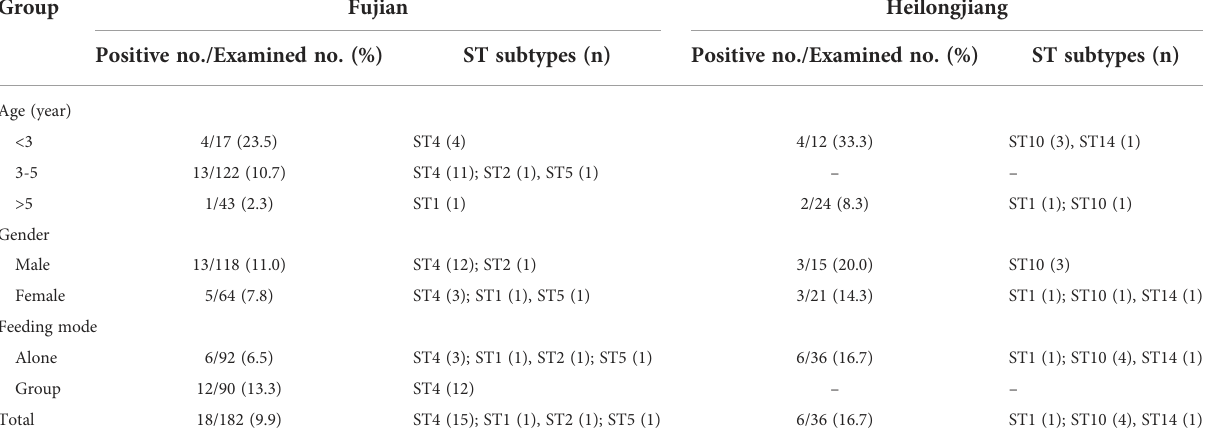
TABLE 1 Prevalence and ST subtypes of Blastocystis in bears from two provinces according to age, gender and feeding mode. Group